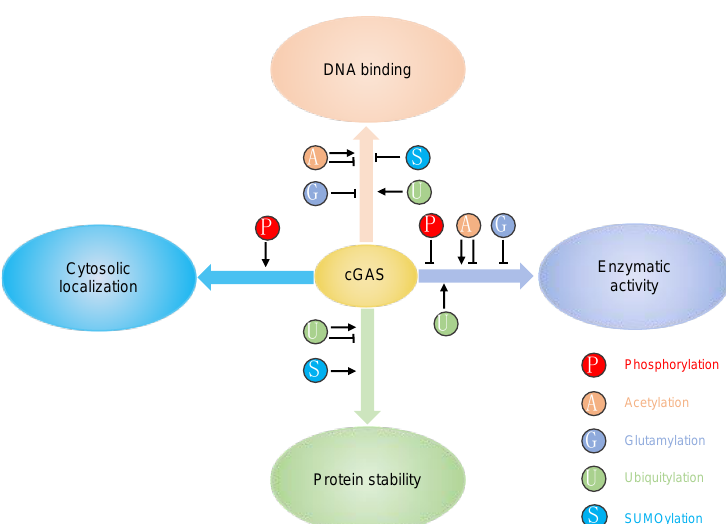
Figure 2. PTMs play a critical role in regulating cGAS enzymatic activity, DNA binding, protein stability and subcellular localization.